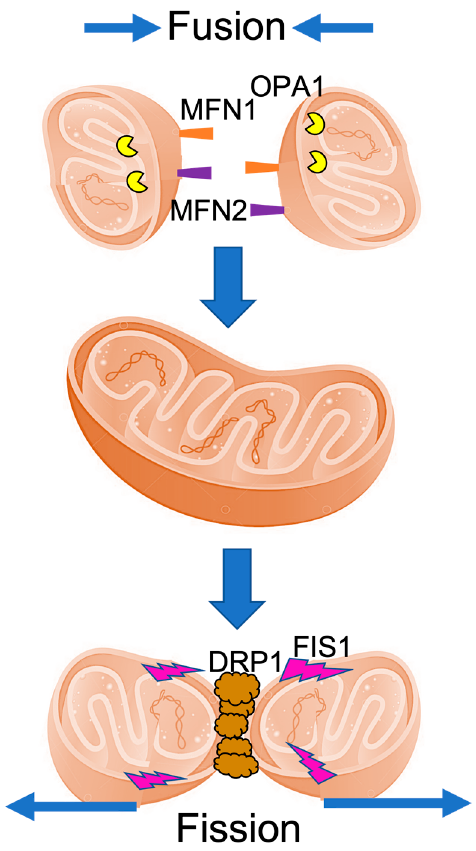
Figure 1. Schematic cartoon of mitochondrial fusion and fission. Mitochondrial fusion occurs when two mitochondria fuse together, whereas fission occurs when one mitochondrion splits into two. Fusion is coordinated on the OMM by the mitofusins (MFN1 and MFN2), and on the IMM by optic atrophy 1 (OPA1). In fission, FIS1 and drp1 are largely involved. Apart from fusion and fission, mitophagy is another critical process that degrades mitochondria through autophagy. PTEN-induced putative kinase 1 (Pink1) initiates the ated in various pathological conditions [61–63] to protect the organelle from dysfunction. Pink1 accumulates on the outer mitochondrial matrix of dysfunctional mitochondria. The increased Pink1 concentration consequentially recruits Parkin, an E3 ubiquitin ligase.